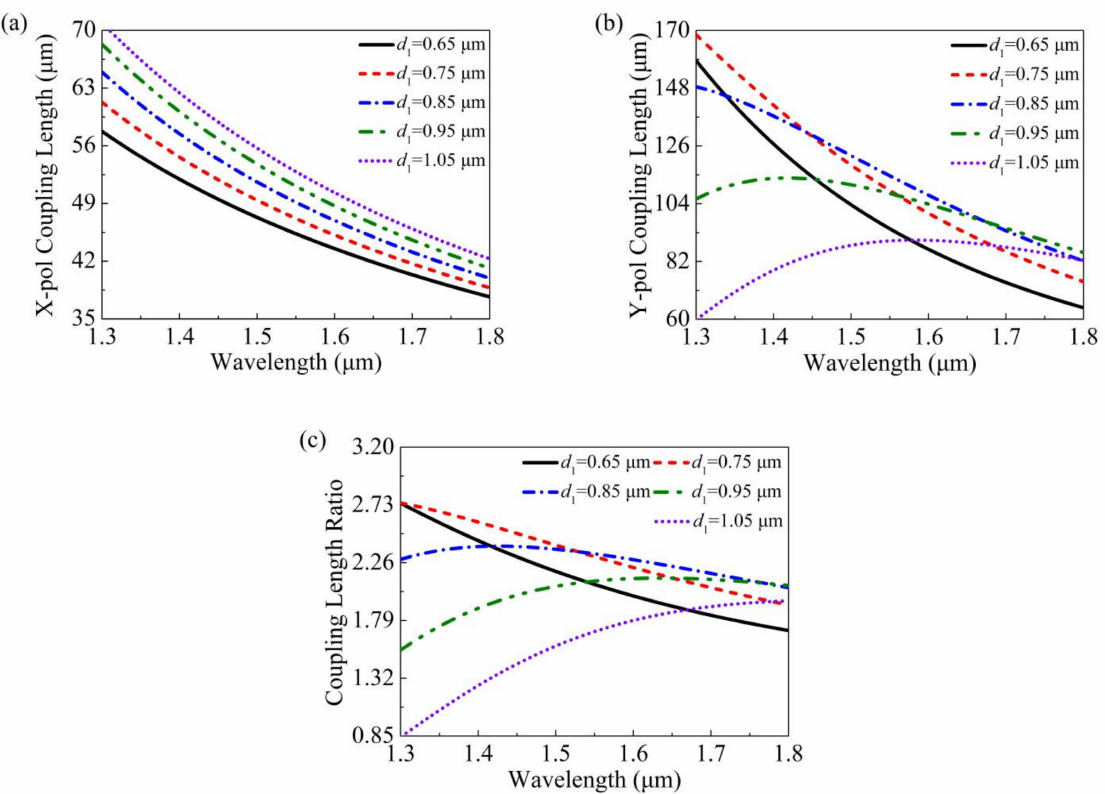
Figure 6. The change rules of the ( a ) CL X , ( b ) CL Y , and ( c ) CLR of the LC-DC-PCF with wavelengths for different d 1 .